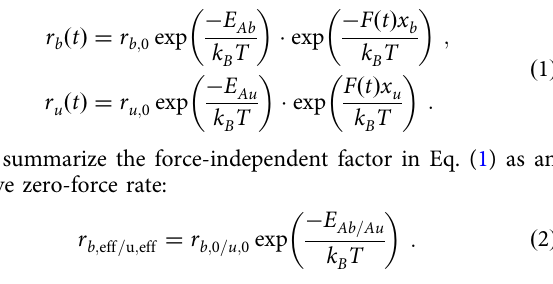
observe spontaneous